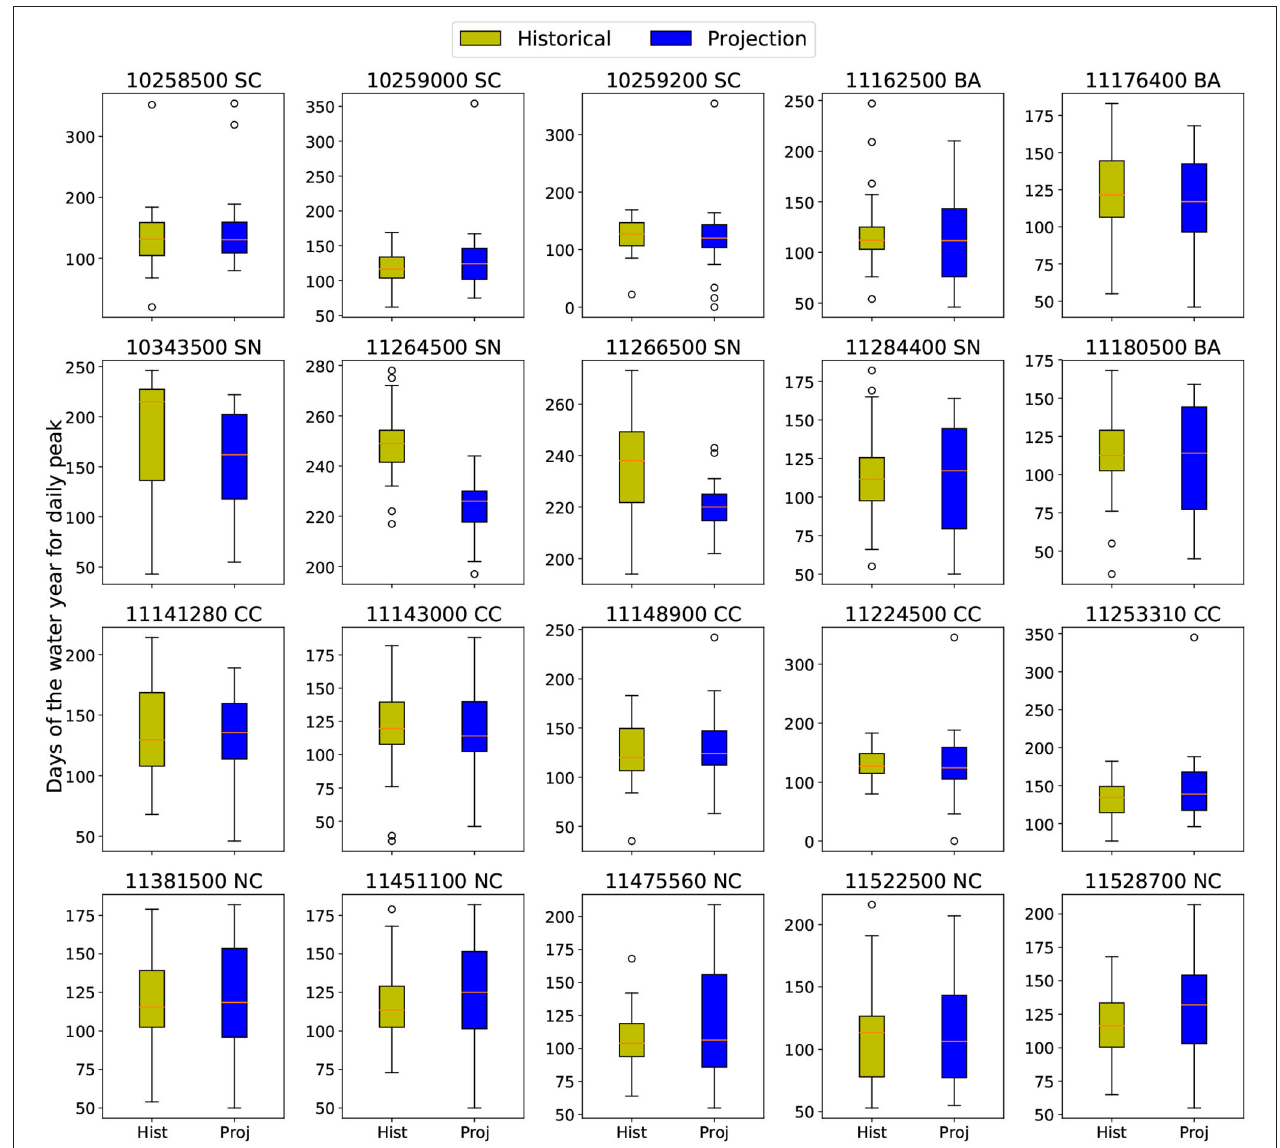
FIGURE 9 | Day of peak flow for each basin with MIROC5